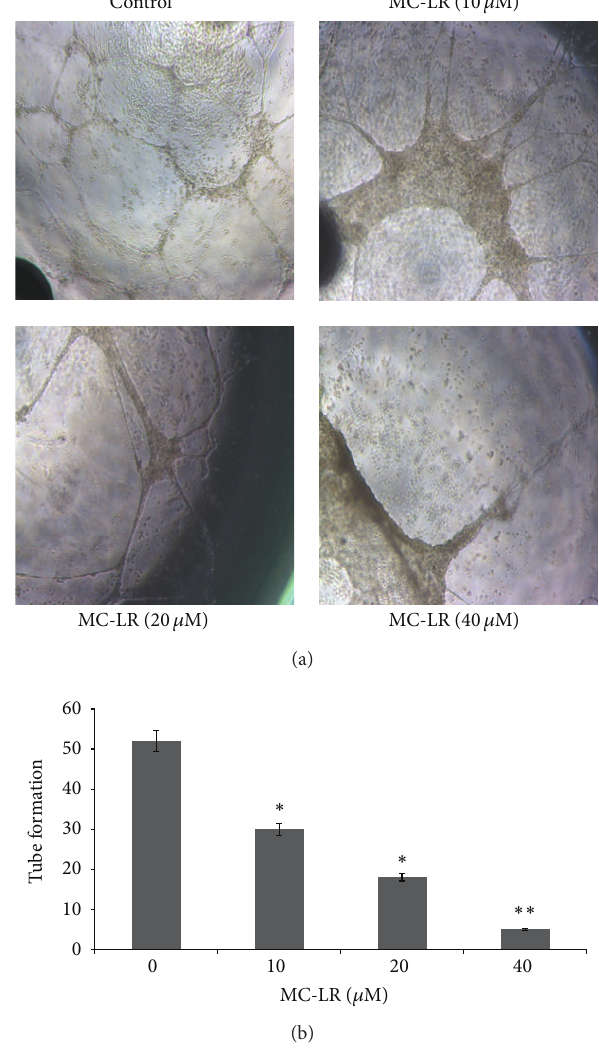
Figure 4: The MC-LR inhibited tube formation of HUVECs was detected by angiogenesis assay. ∗ 𝑝 < 0.05 and ∗∗ 𝑝 < 0.01 versus control ( 𝑛 = 3 independent experiments). The data were shown for three times. Scale bars, 200 𝜇